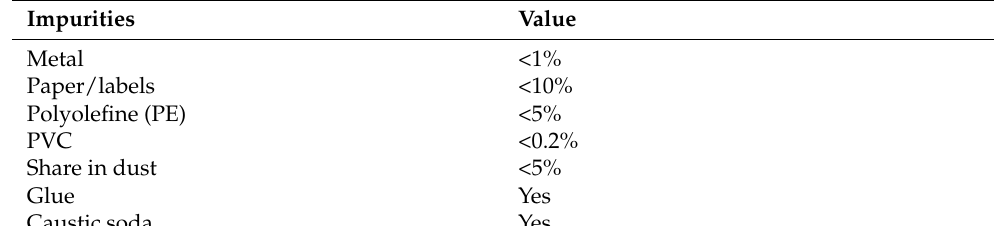
Table 2. Impurities PET fines washed.